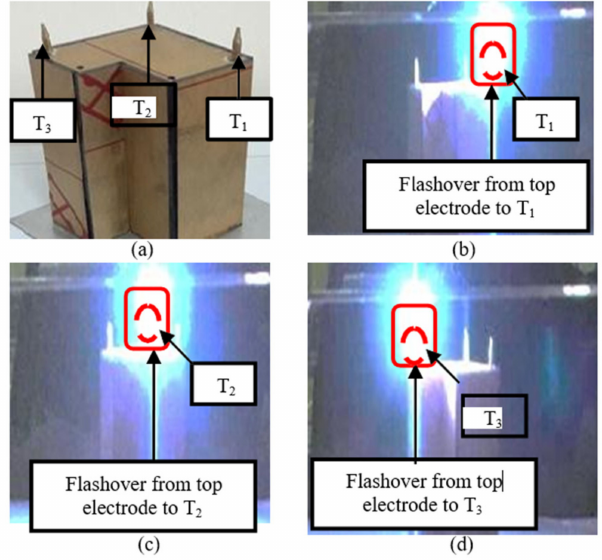
Figure 7. Lightning strike distribution on an L-shape scaled model: ( a ) scaled L-shape model,